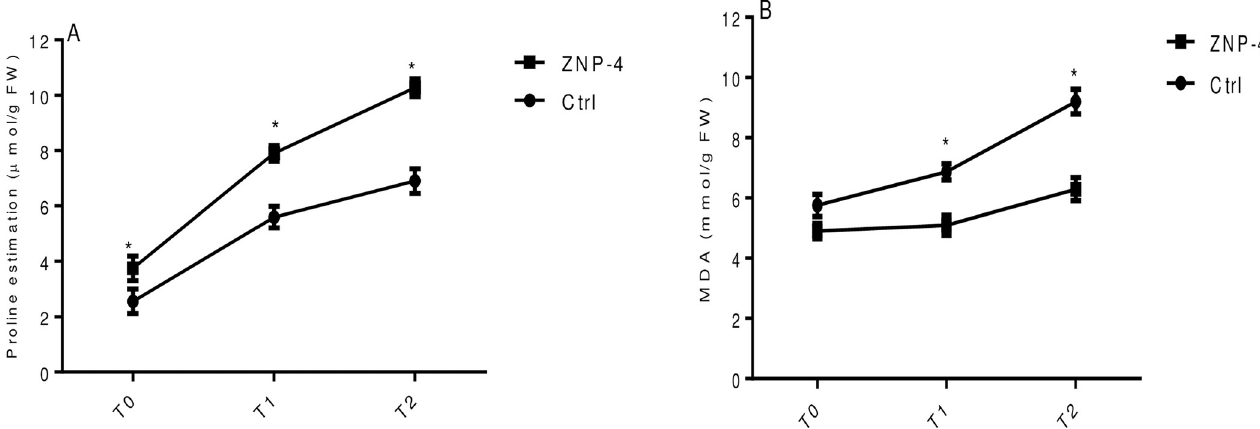
Fig 9. Effect of bacterium inoculation on proline and malondialdehyde content under metal stress (A) proline content (B) malondialdehyde content. Error bar represents standard deviation of five measurements in triplicate sets (n = 15). � represent the significant difference as compared to corresponding control as per Ducan’s multiple range test (p =